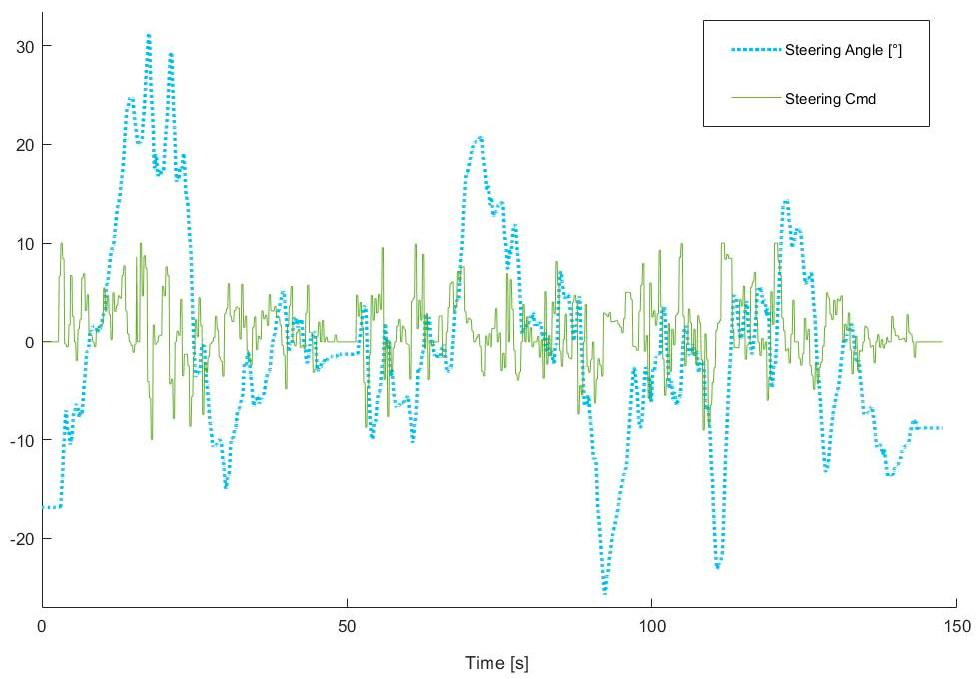
Figure 17. Autonomous System steering commands and LHD steering angle on dataset 14.